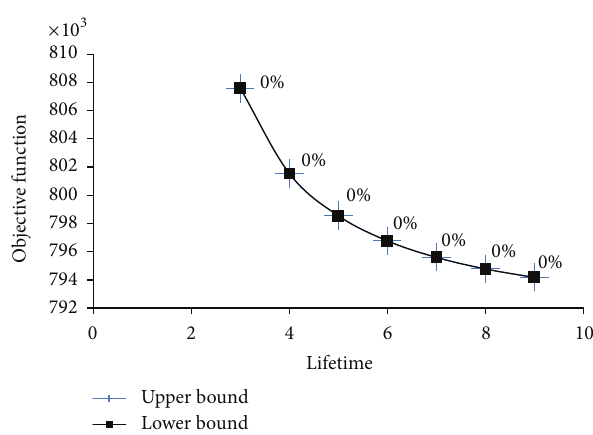
Figure 7: Sensitivity of objective function to changes in inventory cost for 49-node date set.